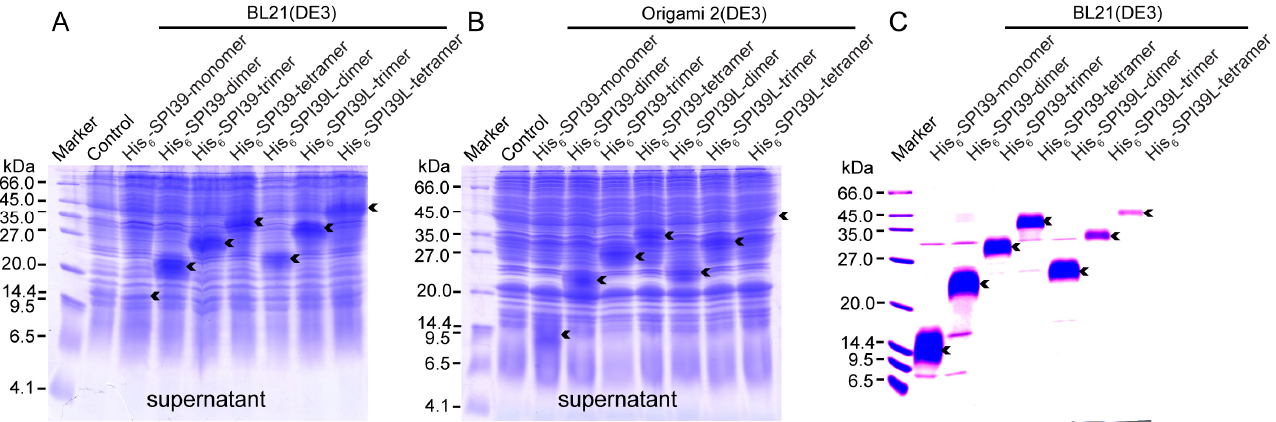
Figure 2. Protein expression and purification of BmSPI39 tandem multimers. ( A ) SDS-PAGE analysis of BmSPI39 tandem multimers expressed in BL21(DE3) cells; ( B ) SDS-PAGE analysis of BmSPI39 tandem multimers expressed in Origami 2(DE3) cells; ( C ) SDS-PAGE analysis of the purified BmSPI39 tandem multimers. The E. coli cells transformed with p28 plasmid were used as the control. “Supernatant” indicates the supernatant part of E. coli cells. Arrows represent the fusion proteins of BmSPI39 tandem multimers. In addition to the target protein bands indicated by the arrows, some weak bands were found, which may be the impurity proteins coeluted with the target